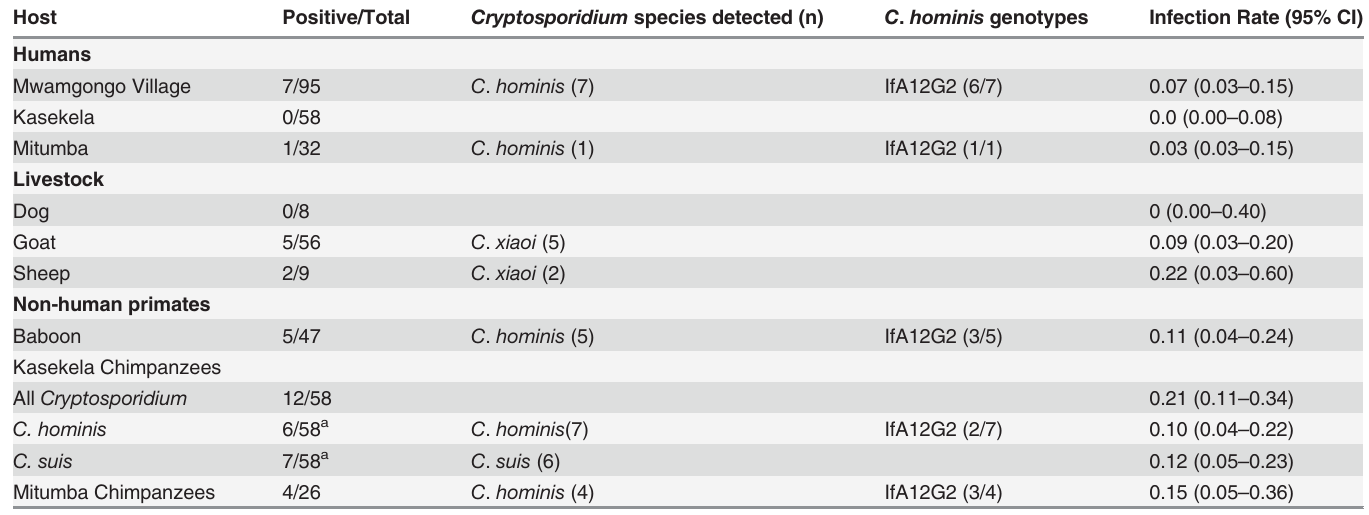
Table 1. Infection rate of Cryptosporidium species and C . hominis subtypes detected by species and location in and around Gombe National Park,